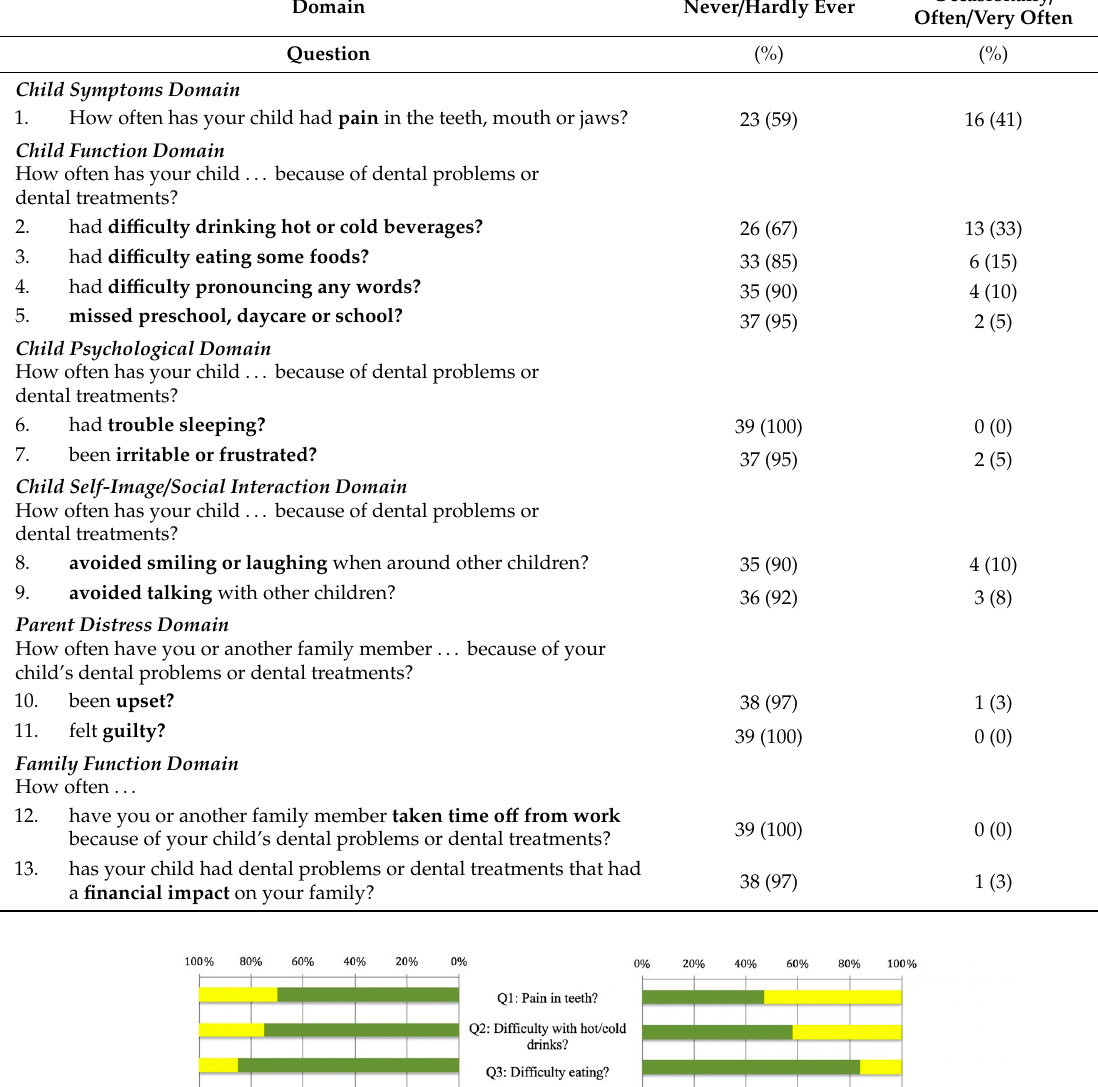
Table 2. Frequency distribution (and percentages) for responses of all β -thalassemia major (BTM) participants (n = 39) to the 13 questions of the Early Childhood Oral Health Impact Scale (ECOHIS). Domain Never / Hardly Ever Question (%) (%) Child Symptoms Domain